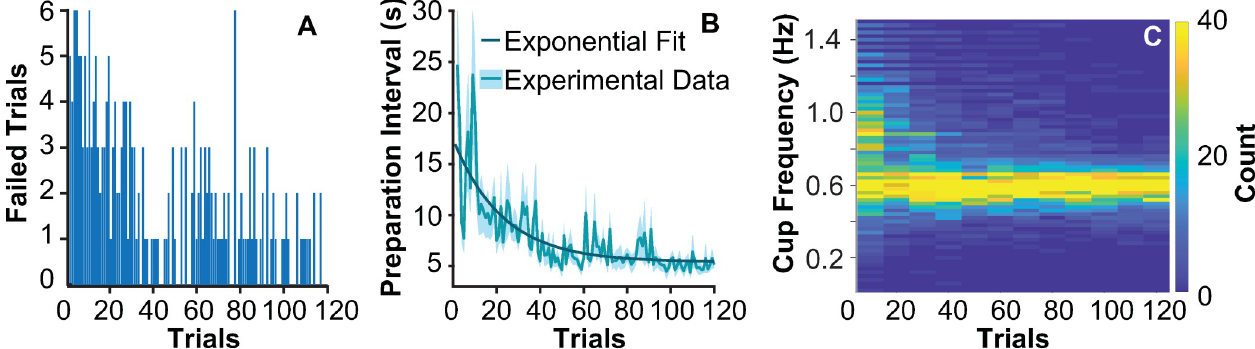
Fig 3. Subject performance: A. Number of subjects that lost the ball for each trial number. B. Duration of the preparation interval averaged across subjects over trials. The fluctuating solid line represents the mean, the shaded area represents the standard error across 11 subjects. The dark solid lines represent the (cid:0) � exponential fit to the data, A 1 þ e (cid:0) t t þ B . The fitted parameters were: A = 12.75, τ = 22.48, B = -7.41, R 2 = 0.60 (see methods and statistical analyses). C. Frequencies of cup cycles for all subjects during the preparation interval, plotted in bins of 10 trials. The color gradient denotes the number of cycles in each frequency bin; yellow shows high numbers.